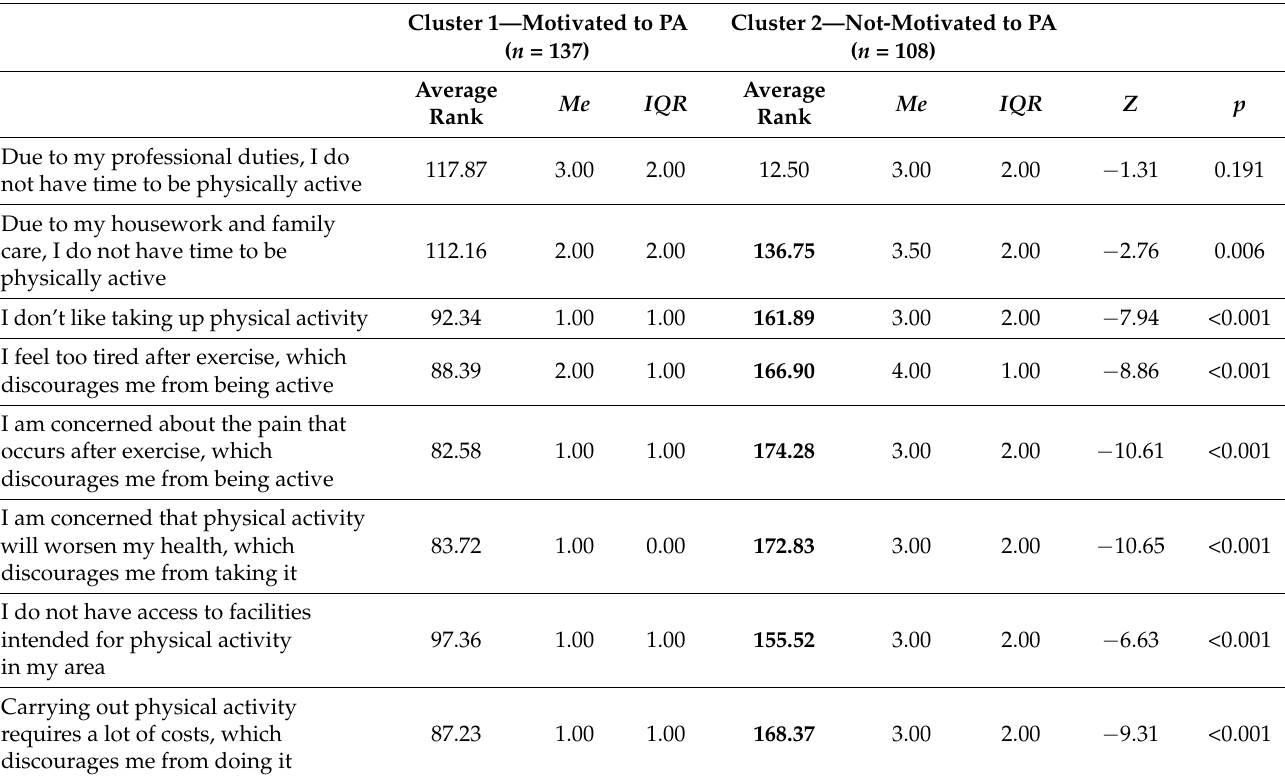
Table A4. The details results of the differences between group motivated to PA and not-motivated